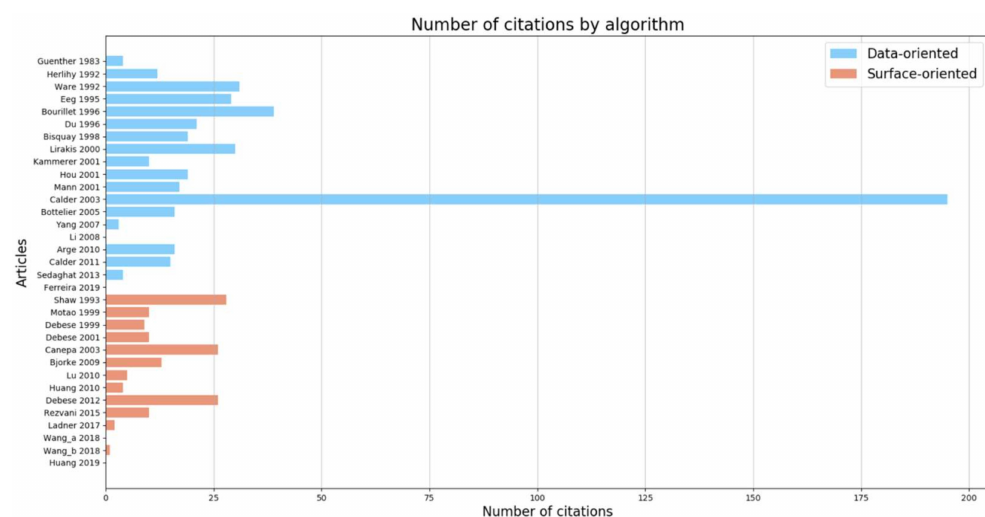
Figure 8. Number of citations per algorithm (as extracted from Google Scholar 30 / 01 /